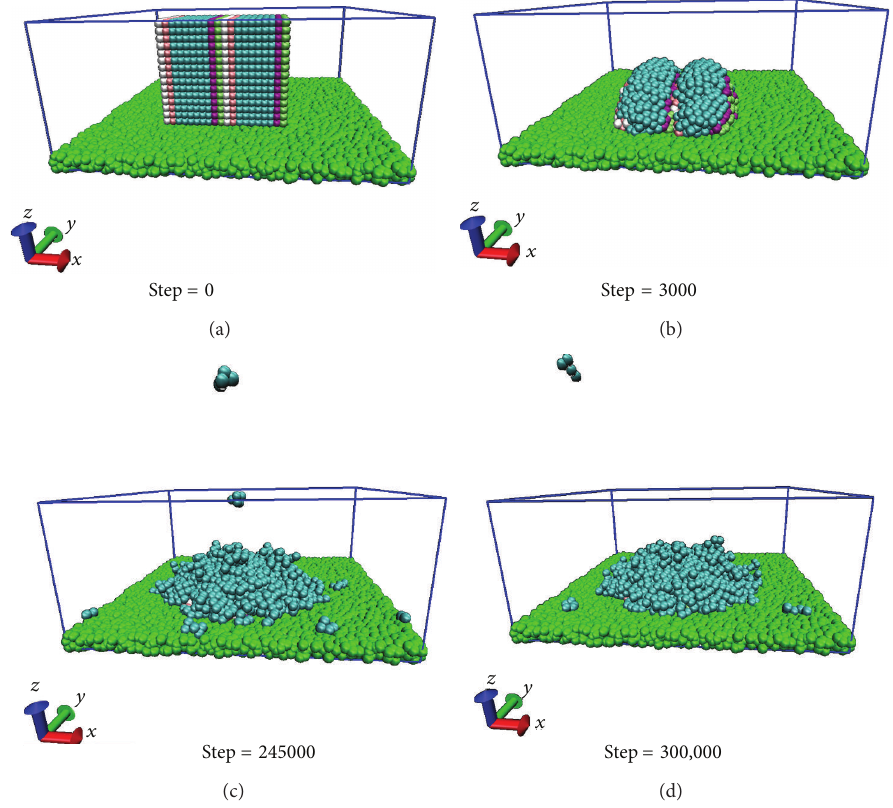
Figure 11: Snapshots of PFPE Ztetraol on a DLC substrate at different time steps: (a) at step = 0; (b) at step = 3000; (c) at step = 245000; (d) at step = 300,000 at temperature 𝑇 ∗ = 3 (501K = 228 ∘ C) with